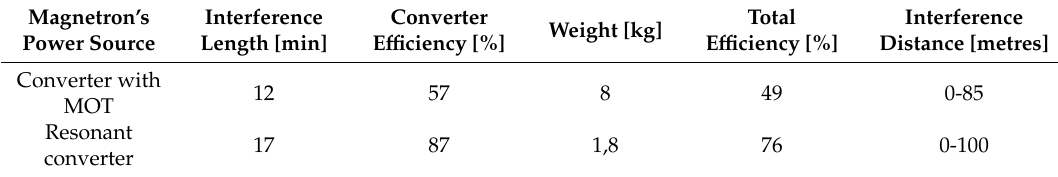
Table 4. Overall results of optimising the magnetron’s power